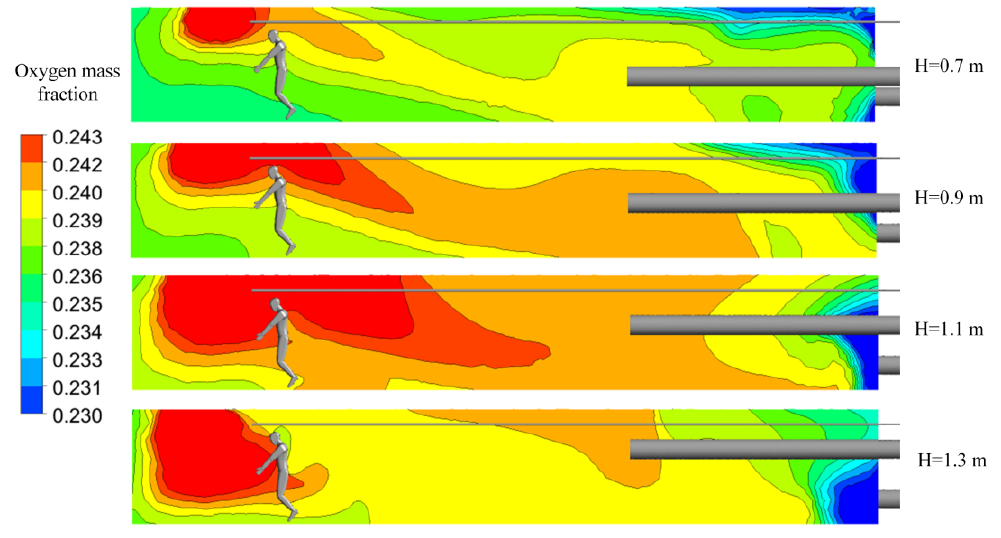
Figure 7. Distributions of oxygen mass fractions at section X = 0 m.